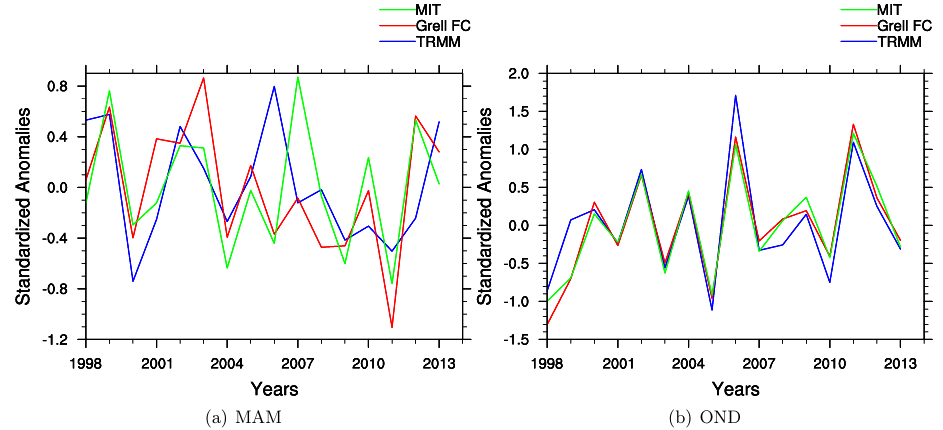
Figure 7. Inter-annual precipitation variability for standardized seasonal rainfall anomalies over East Africa during ( a ) Long Rains and ( b ) Short Rains from